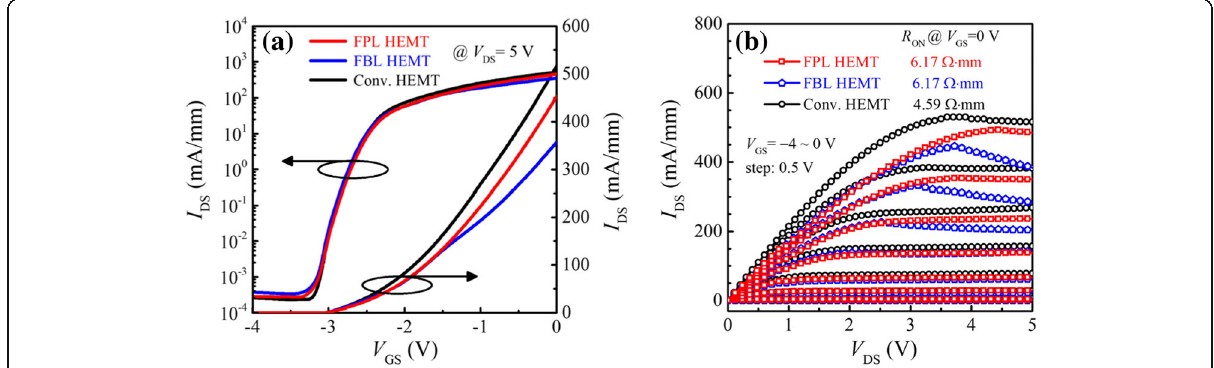
Fig. 3 Measured a I-V transfer characteristics, and b DC output characteristics for three